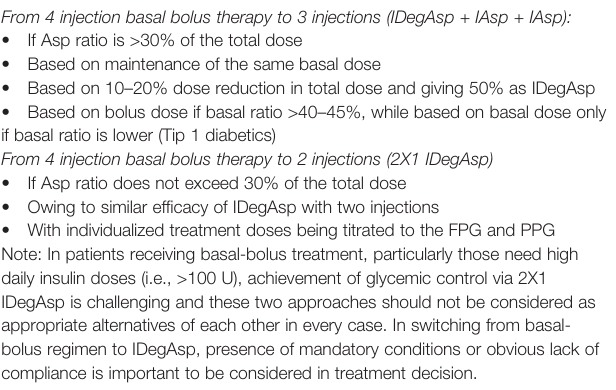
TABLE 5 | Expert Panel Recommendation 5: Switching from basal-bolus regimen.